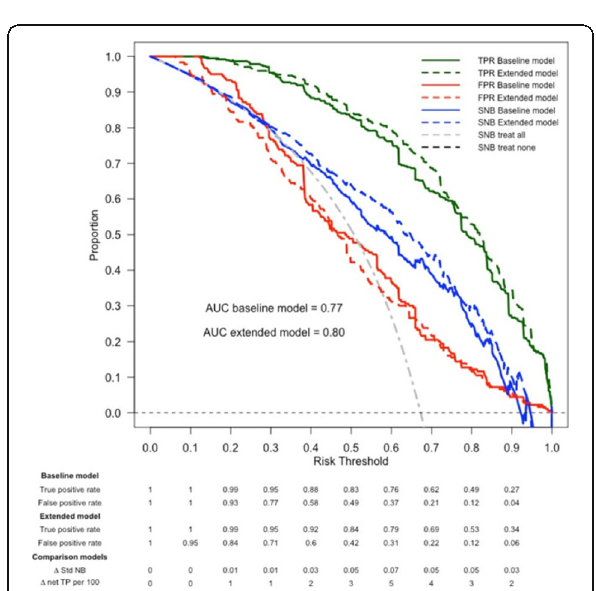
Fig. 2 (abstract O35). Classification plots including standardized decision curve for the baseline and extended model combined, to predict the risk of metastatic remnants after chemotherapy in testicular cancer